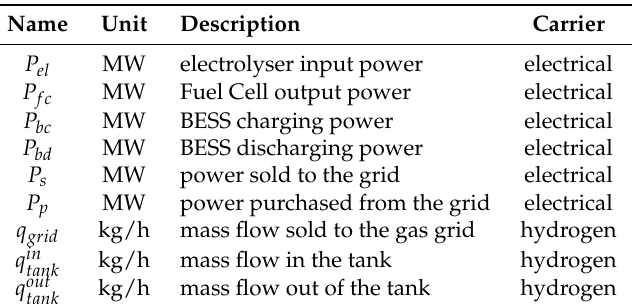
Table 1. Real valued decision variables.